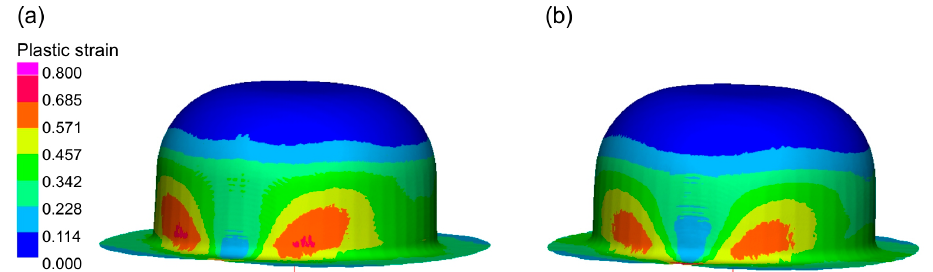
Figure 11. Plastic strain distribution on the drawn part surface: ( a ) dry friction; ( b ) with lubricant.